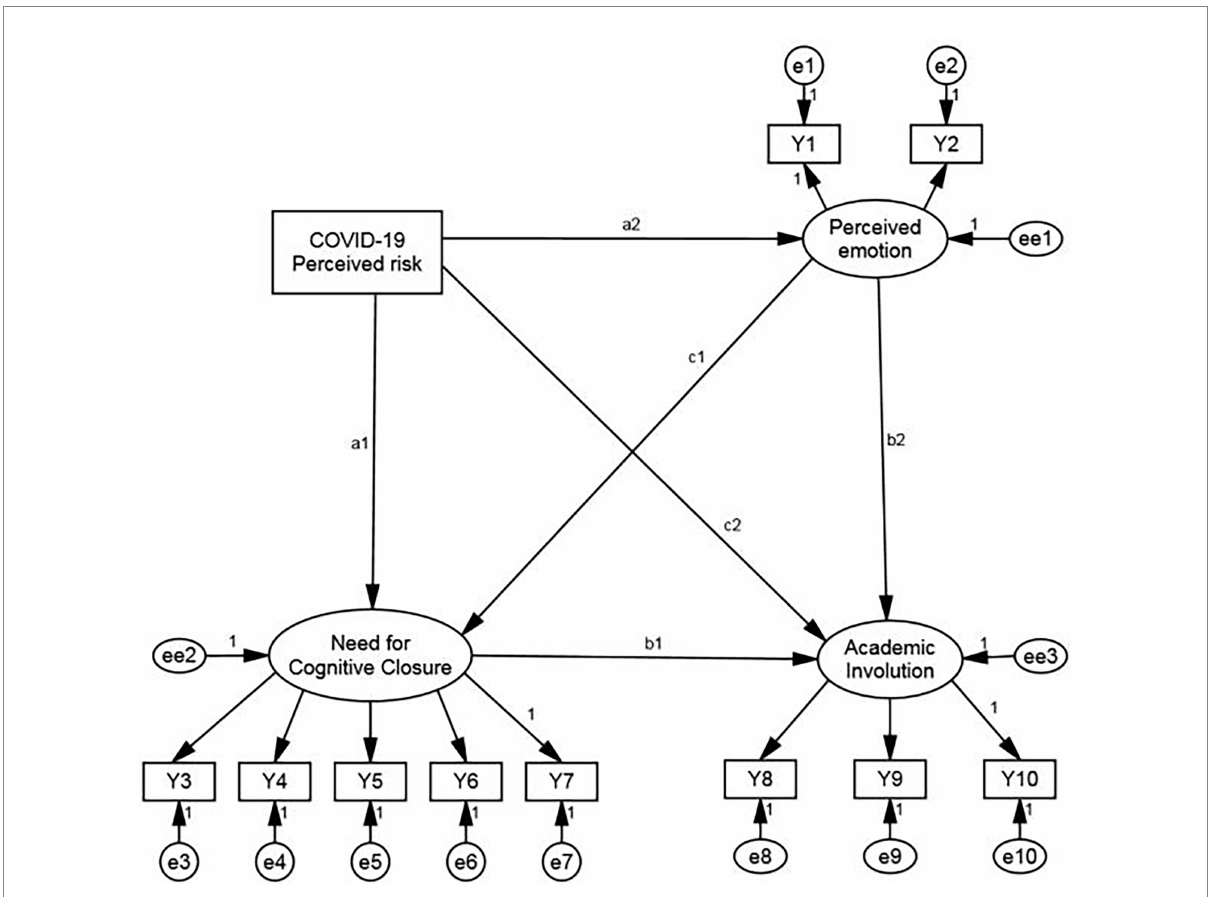
FIGURE 1 Path analysis with latent variable